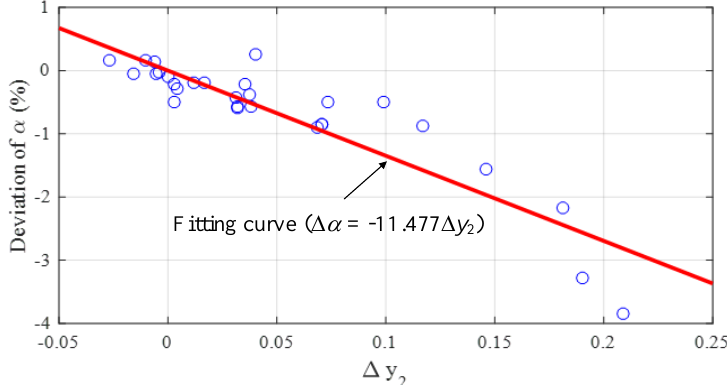
Figure 5. Deviation of A versus the undershoot factor ( D y 2 ) and the fitted curve.